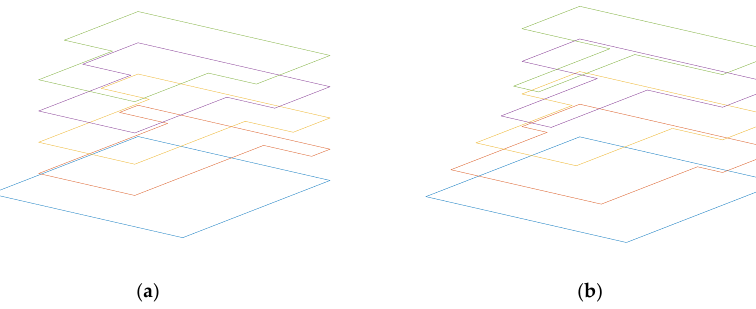
Figure 4. Overlay illustration of the variation of ratio of ( a ) the mass length (Mass_L) to the beam length (Beam_L) and ( b ) the mass width (Mass_W) to the beam width (Beam_W).